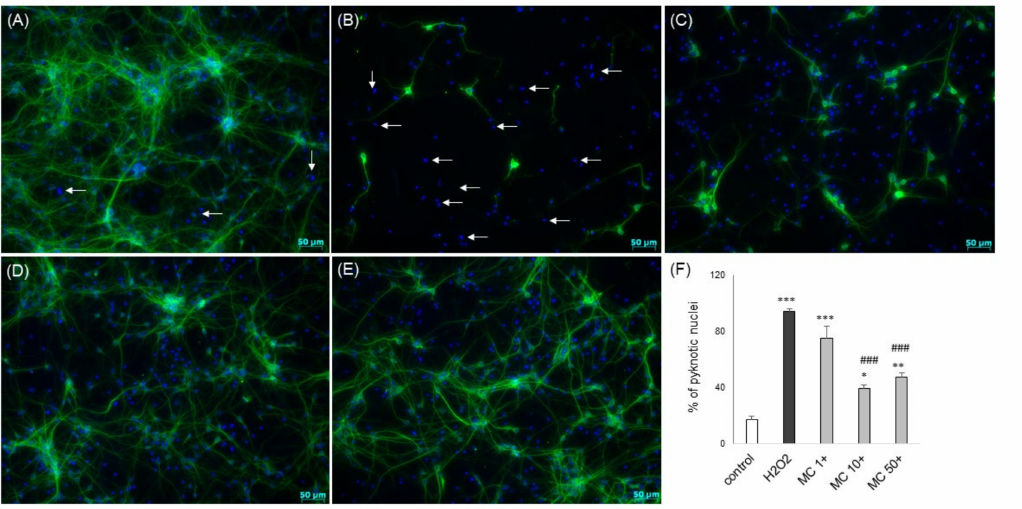
Figure 11. ( A – E ) Representative microphotographs of primary neurons pre-treated for 30 min. with MC (1–50 µ M) followed by 24 h of exposure to H 2 O 2 (0.2 mM). After the treatment the cells were fixed and immunostained with a neuronal marker (anti-MAP-2, green) and contrastained with nuclear dye Hoechst 33,342 (blue; examples of pyknotic nuclei are indicated by arrows). ( A )—control; ( B )—H 2 O 2 ; ( C )—H 2 O 2 + MC 1; ( D )—H 2 O 2 + MC 10; ( E )—H 2 O 2 + MC 50. ( F ) Histogram showing an estimation of the number of pyknotic nuclei from Hoechst 33,342 staining. Nuclei showing bright blue florescence (condensed or fragmented) were semi-manually counted and presented as the mean percentage of pyknotic nuclei / all nuclei ± SEM. *** p < 0.001, ** p < 0.01 and * p < 0.05 vs. vehicle-treated cells; ### p < 0.001 vs. H 2 O 2 -treated